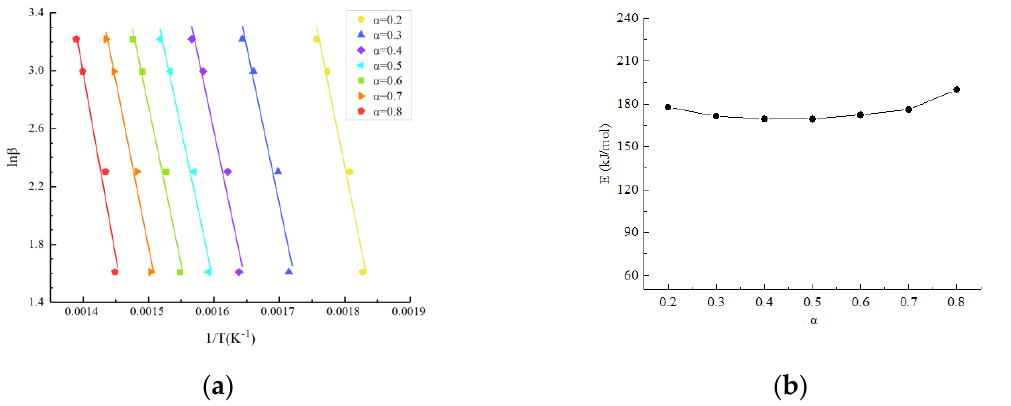
Figure 4. Results at different conversion rates based on the Flynn–Wall–Ozawa method: ( a ) linear fitting curves; ( b ) activation energy results.